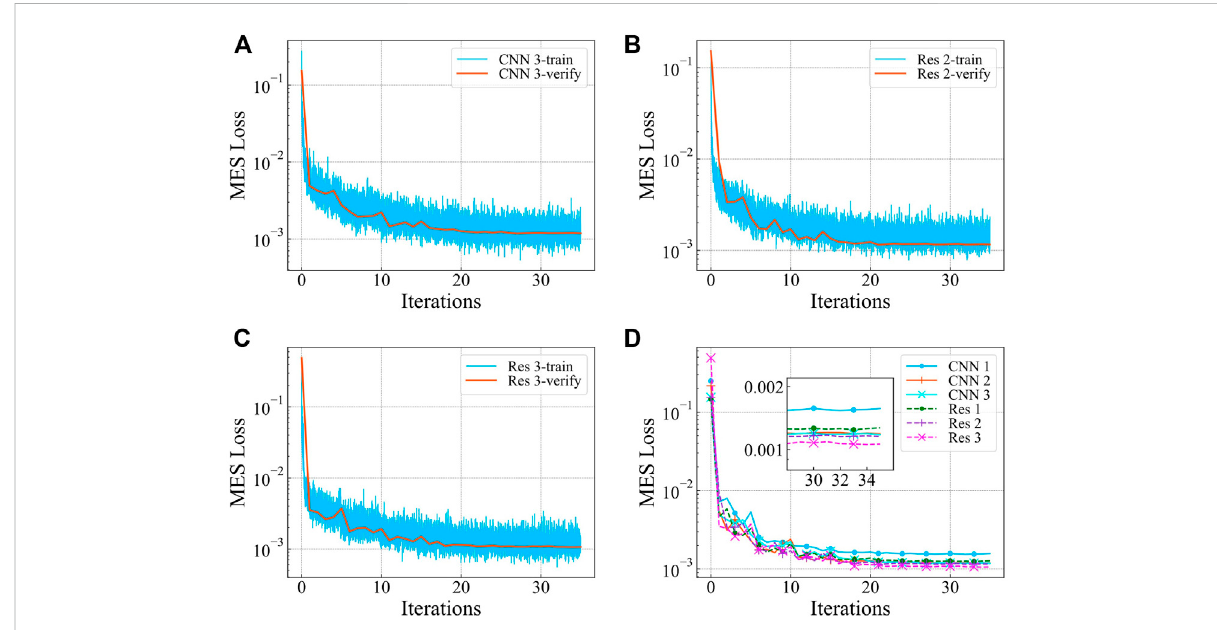
TABLE 1 The error distribution of each neural network in the predicted value of the lift-to-drag ratio in the veri fi cation set. Network